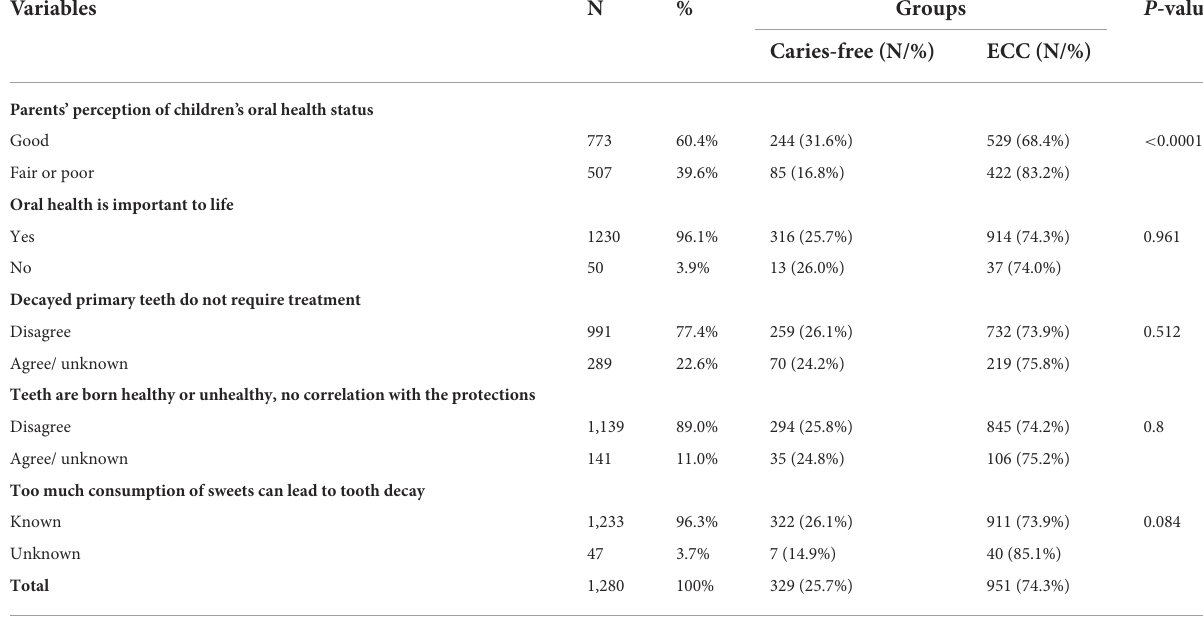
TABLE 3 Prevalence of ECC and parental oral health awareness and attitude ( N = 1,280).